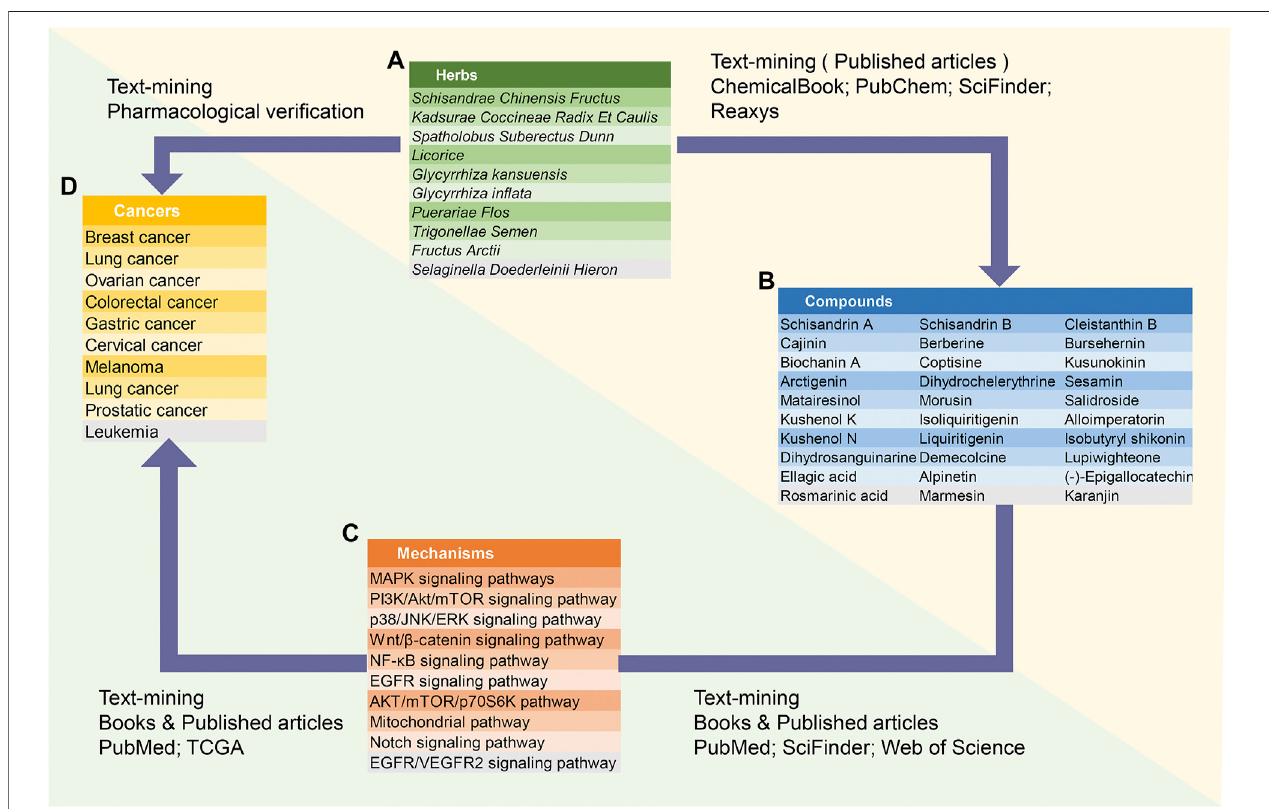
FIGURE 1 | Database structure. ACNPD is composed of compounds, traditional Chinese medicine sources, cancer types, and regulatory mechanisms. The relationship between the four key modules in ACNPD are described. Notably, the yellow triangle area represents the basic chemical information and the green triangle area represents the pharmacological mechanism contents.